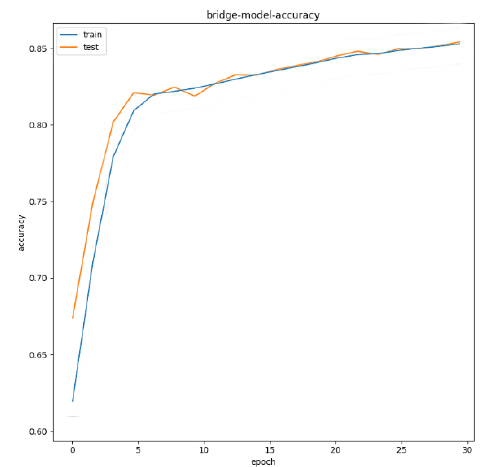
Figure 22. Accuracy of bridge target recognition.